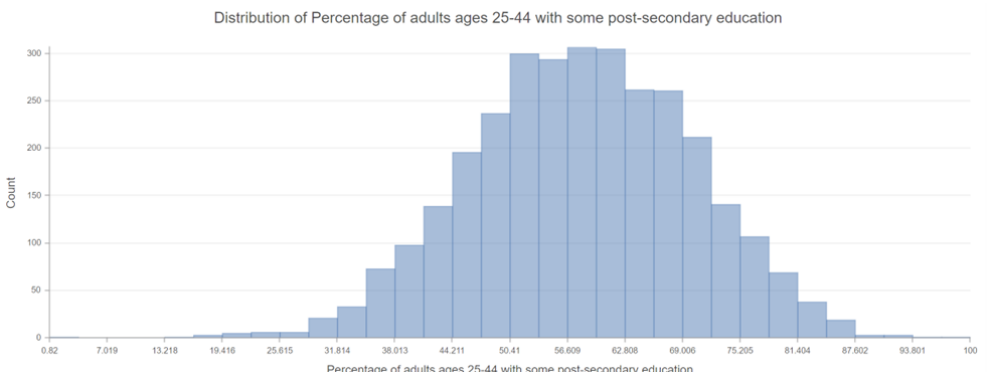
Figure 4. Distribution of Post-Secondary Education.